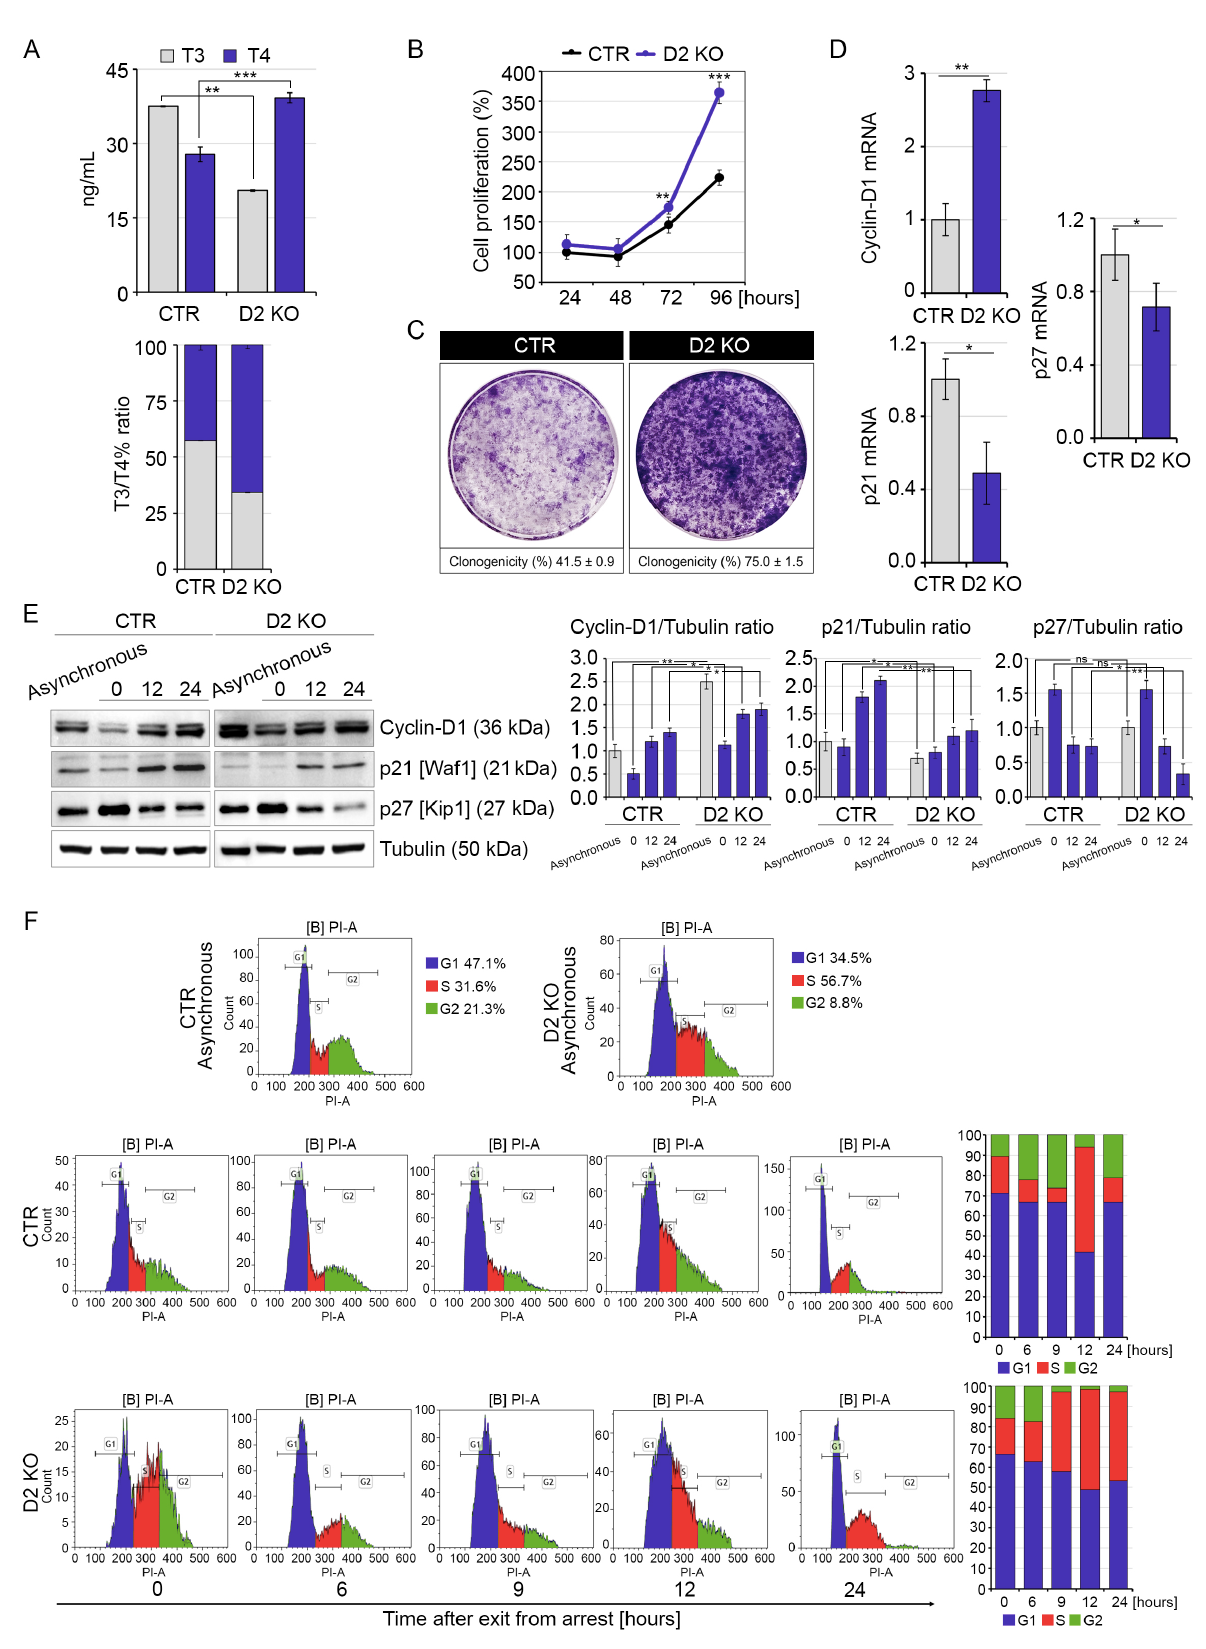
Figure 1. D2 knock-out promotes cell division rate and progression through the cell cycle compared to CTR cells. ( A ) Levels of T3 and T4 measured by HPLC-MS in the culture medium of D2 KO and CTR cells (top). The same levels are expressed